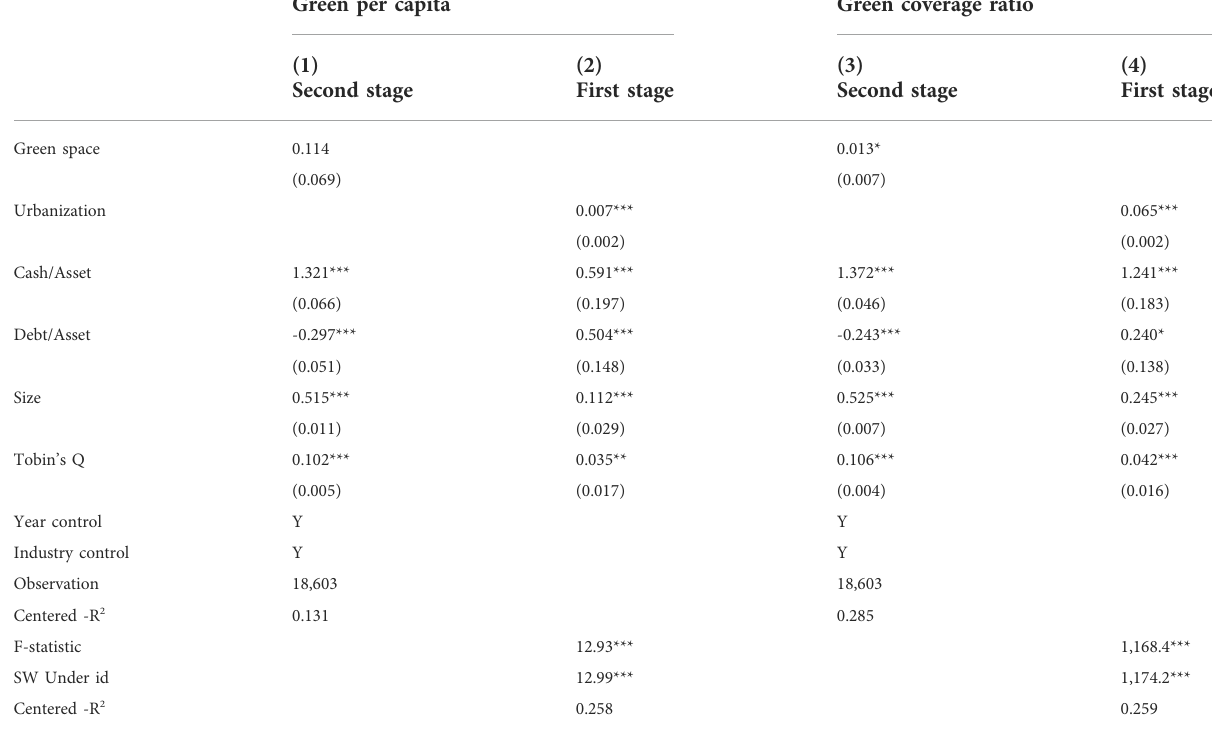
TABLE 5 Two-stage IV estimation of urban public green spaces and fi rms ’